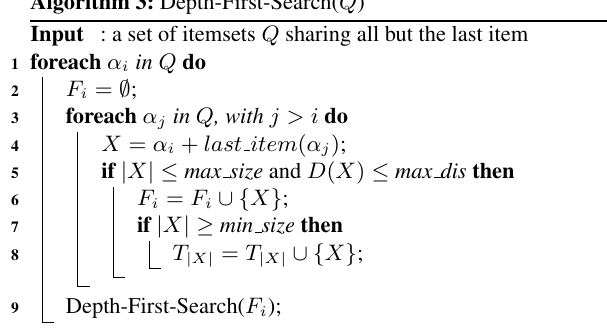
Algorithm 3: Depth-First-Search( Q